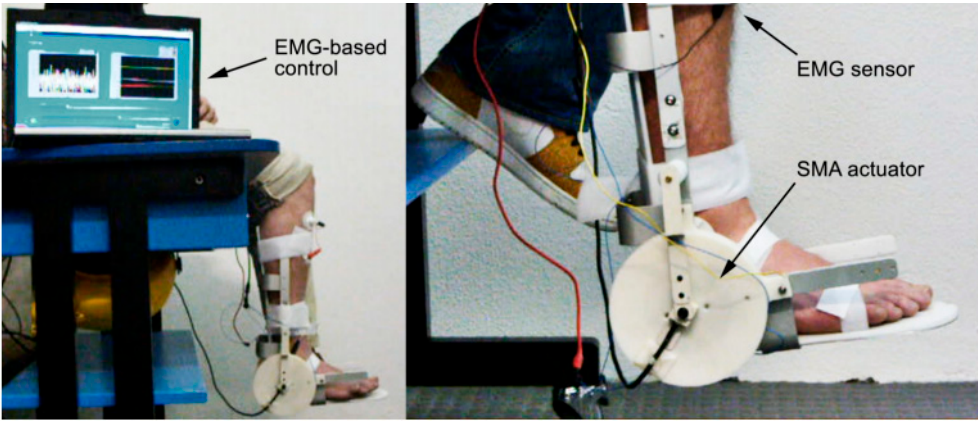
Figure 32. EMG-controlled SMA device for assisted ankle exercise [32].